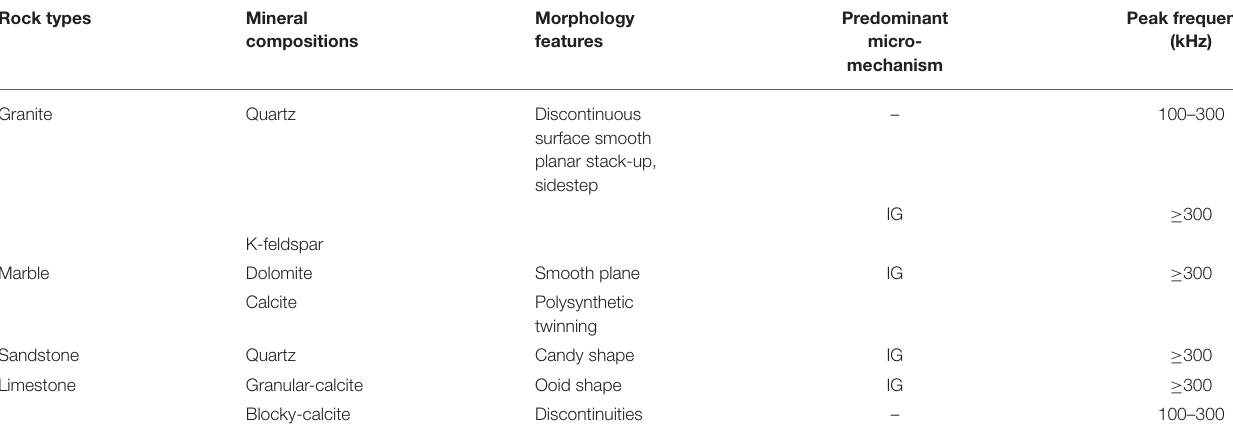
TABLE 2 | The micro-fracture characteristics of four type rocks under Brazilian split